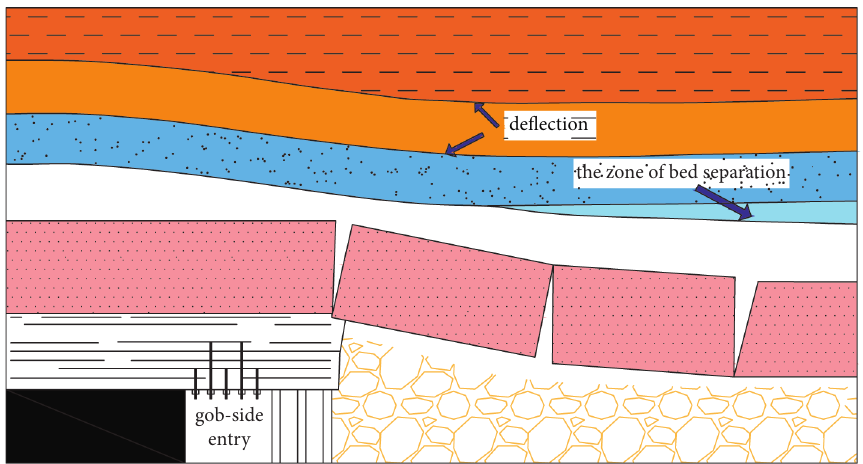
Figure 1: Flexure and breakage of the roof.